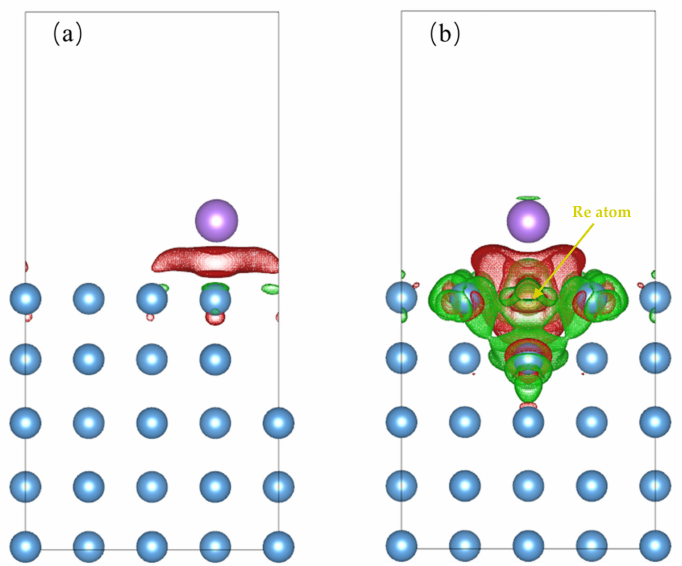
Figure 4. Difference charge density of Na adsorption at the hollow site of ( a ) Mo (110) surface and ( b ) Mo-Re (110) surface. The red isosurface represent the electron accumulation region, while the green isosurface represent the electron depletion region. The Re atom is located in the center of Mo (110) surface, as shown in Figure